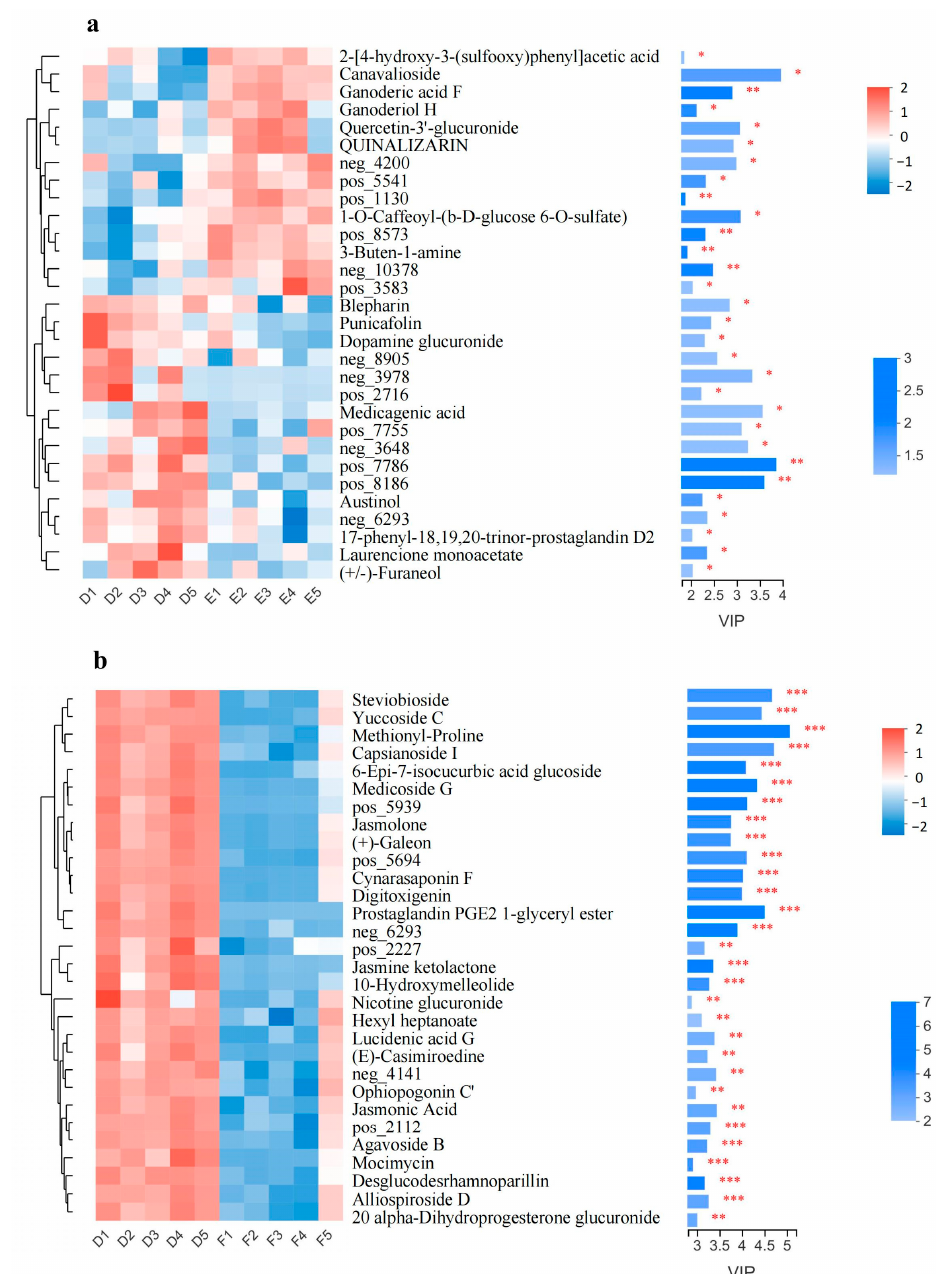
Figure 7. The top 30 SCMS with VIP value > 1 and p < 0.05 in CO seedlings under cold stress, ( a ) E vs. D ( b ) F vs. D. The VIP bar chart of the SCMs is on the right. The bar color indicates the significant difference ( p _Value) of metabolites between the two treatments, the smaller the value, the larger the − log10 ( p _Value) and the darker the color. Asterisk (*) indicates p < 0.05, asterisk (**) indicates p < 0.01, asterisk (***) indicates p < 0.001. D, C. oleifera treated with 20 °C; E, C. oleifera treated with 4 °C; F, C. oleifera treated with − 4 °C